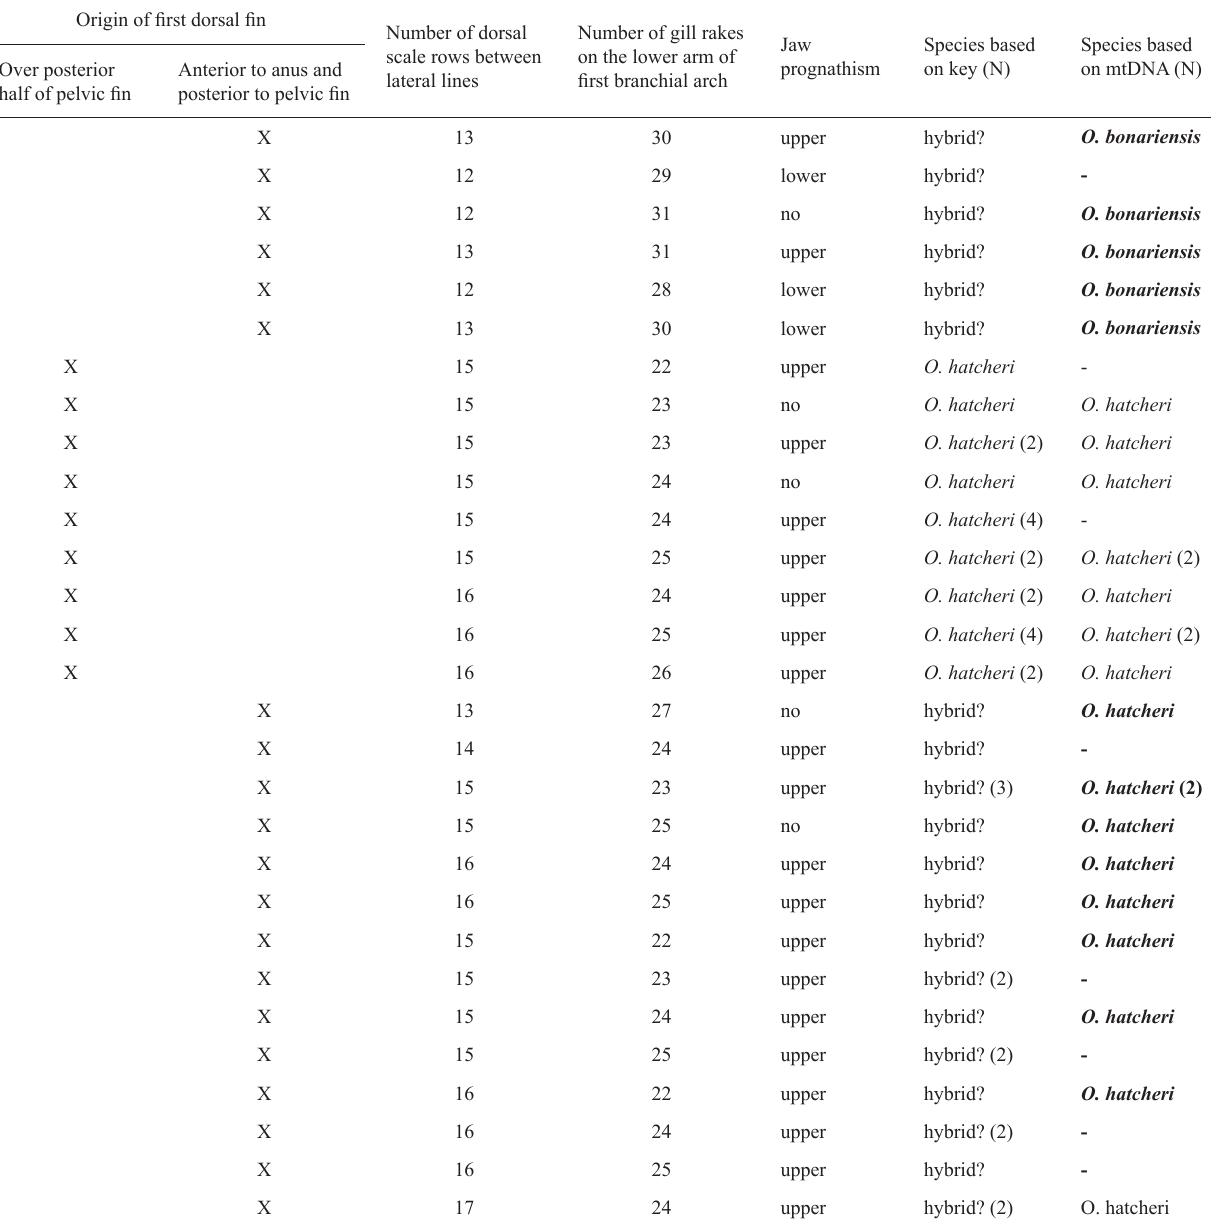
Table 2. Meristic and morphological characters applied to the identification (following Dyer, 2006) of 45 individuals from Lake Pellegrini. Results from mtDNA analysis are compared with identification based on taxonomic key: origin of first dorsal fin over posterior half of pelvic fin ( O. hatcheri ) or anterior to anus and posterior to pelvic fin ( O. bonariensis), number of dorsal scale rows between lateral lines >12 ( O. hatcheri) or <11( O. bonariensis); number of gill rakes on the lower arm of first branchial arch, 21-27 ( O. hatcheri) or >30 (32-38) ( O. bonariensis) ; upper jaw prognathous ( O. hatcheri) or lower jaw prognathous in large specimens ( O. bonariensis). N: number of specimens. In bold, the presumptive hybrids individuals identified on meristic and morphological characters, those are highlighted with * in Fig.